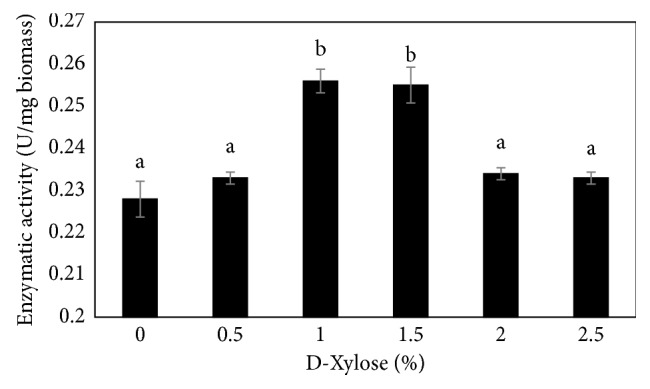
The effect of the concentration of D-xylose on glucose isomerase production. We found that the increase of concentration of D-xylose (1–1.5%) will result into improvement of bacterial growth and activation of glucose isomerase biosynthesis. However, the higher concentration of D-xylose (2–2.5%) could inhibit the bacterial growth, which decreased enzyme activity. Statistical analysis revealed no significant difference between 1% and 1.5% D-xylose on enzyme production; therefore, we chose 1% of D-xylose for further optimization experiments. a and b indicate the significant difference between groups.